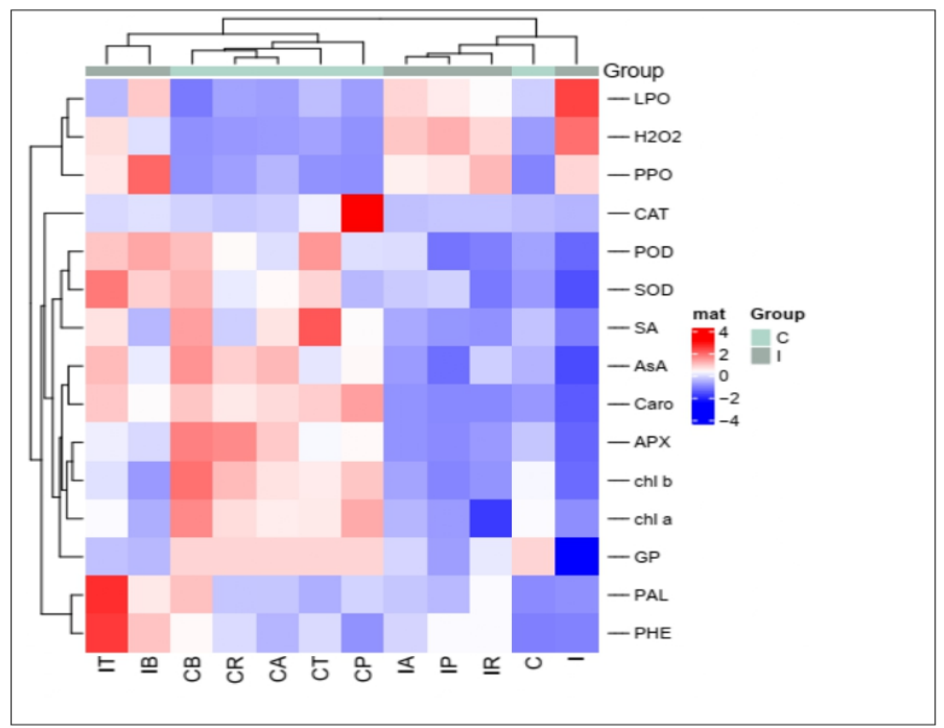
Figure 10. Heatmap analyses for physiological traits of healthy and R. solani -infected coriander treated with biocontrol agents.